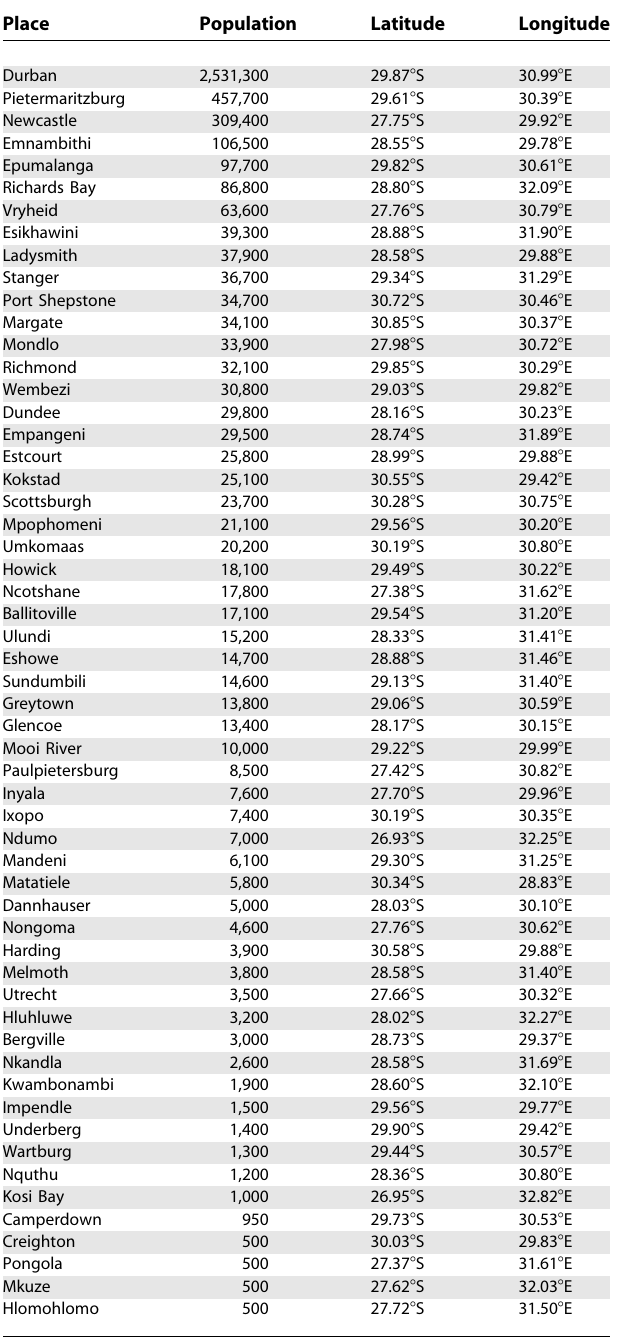
Table 2. HCFs Proposed for Use in the Rollout of ARVs in KwaZulu–Natal District Facility Name Latitude Longitude